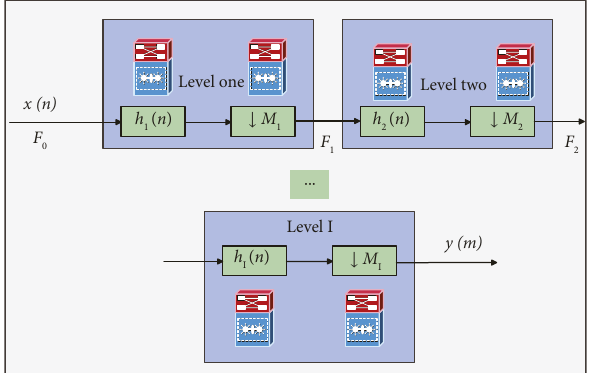
Figure 3: Schematic diagram of the workflow of the multistage decimation